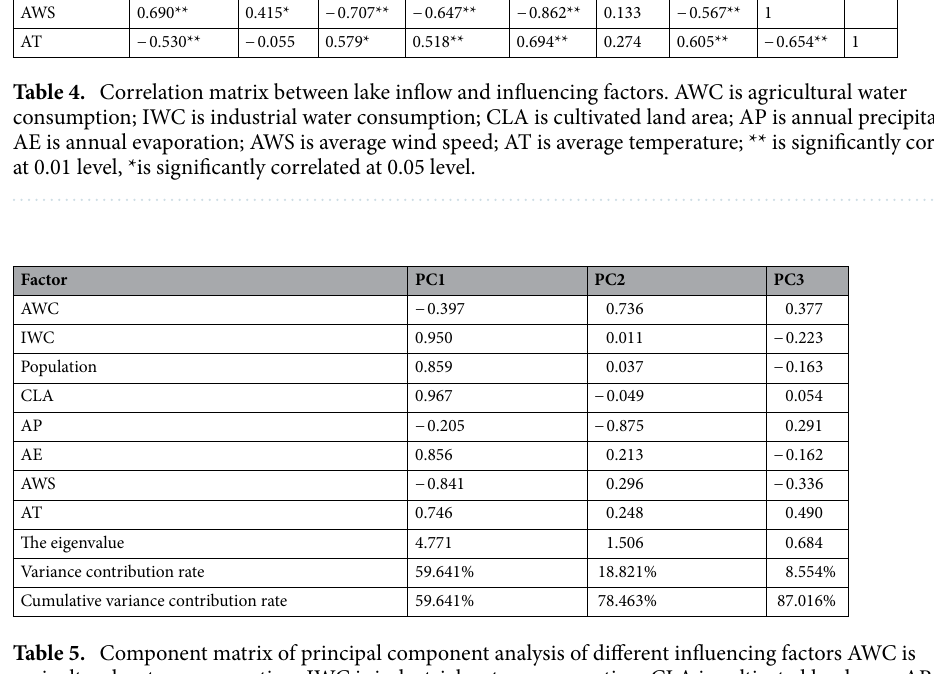
Table 5. Component matrix of principal component analysis of different influencing factors AWC is agricultural water consumption; IWC is industrial water consumption; CLA is cultivated land area; AP is annual precipitation; AE is annual evaporation; AWS is average wind speed; AT is average temperature; PC1 is the first principal component; PC2 is the second principal component; PC3 is the third principal component.